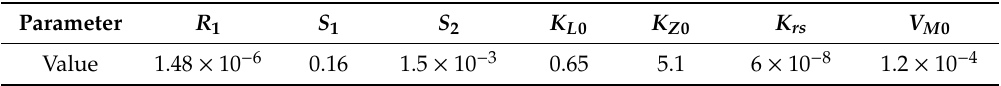
Table 1. Main parameters of cylindrical roller